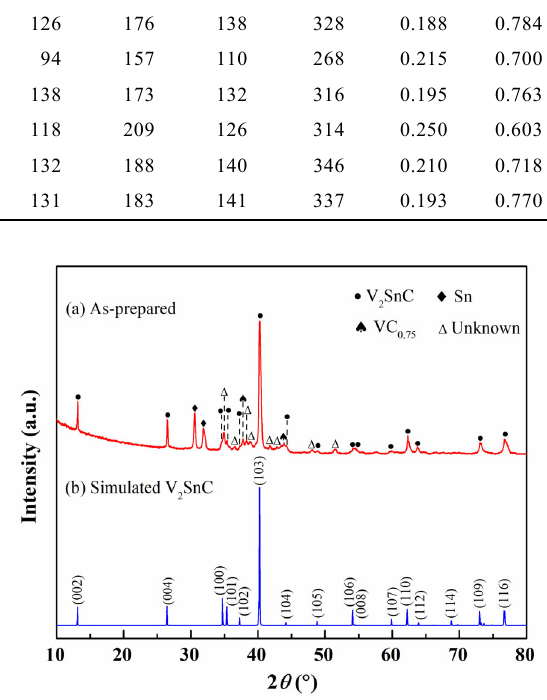
Fig. 3 Comparison between XRD patterns of (a) powders synthesized through the reaction between V, Sn, and C at 1000 ℃ for 2 h and (b) the simulated one of V 2